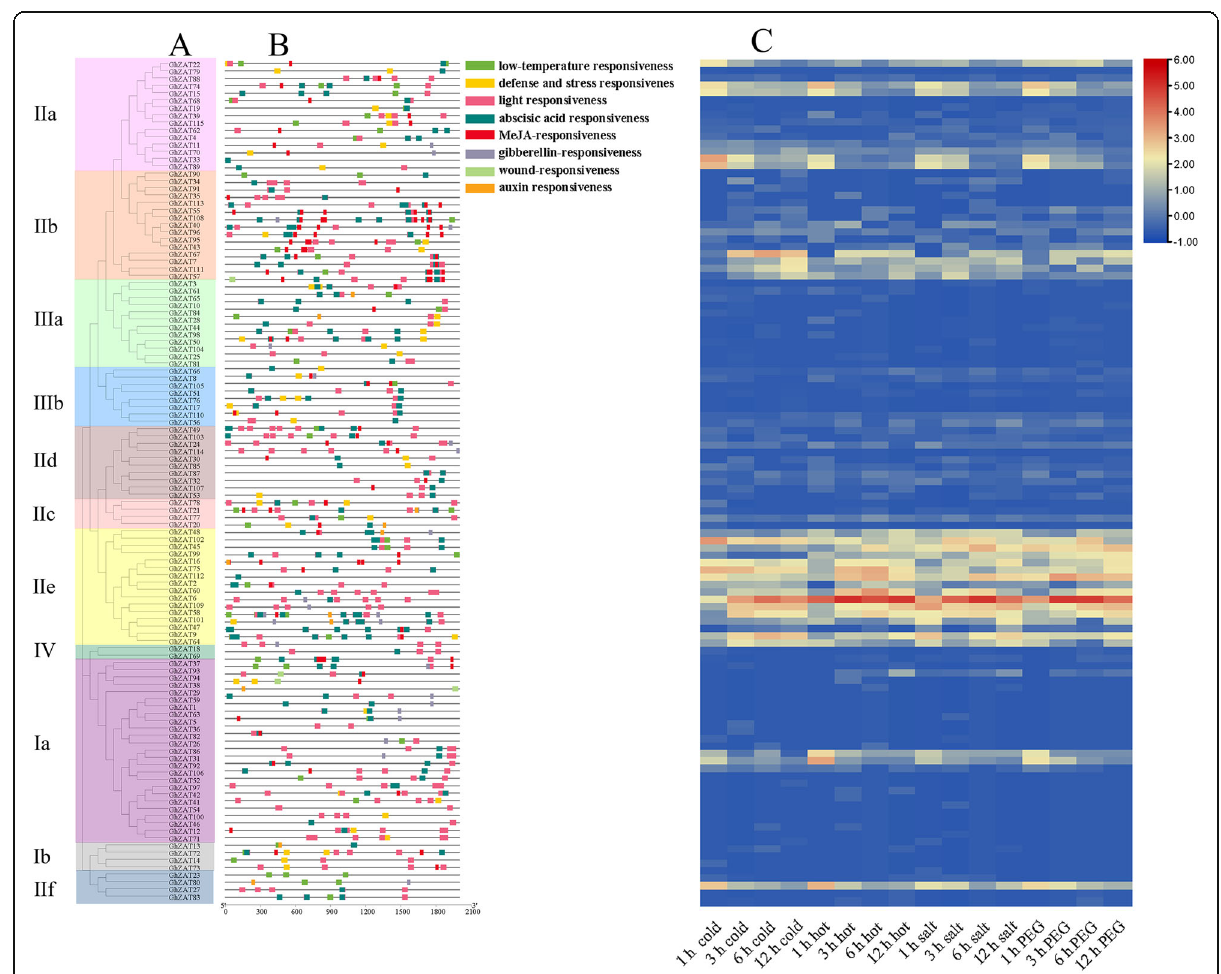
Fig. 7 Analysis of promoters and differentially expressed genes of GhZAT family. A: Phylogenetic tree of GhZAT genes; B: Cis -elements in promoters of GhZAT genes; C: Heatmap of differentially expressed genes (DEGs) of GhZAT genes under cold, hot, salt, and PEG